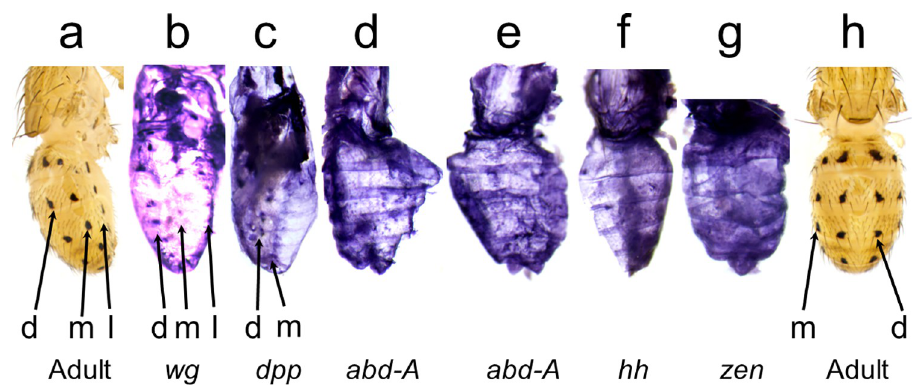
Fig 5. The mRNA expression patterns of wg and dpp show correlation with y expression in adult D . deflecta . a, h, Adult D . deflecta lateral and dorsal view. b, c, Lateral view. Developmental gene expression patterns of wg and dpp at pupal stage P7 in D . deflecta foreshadow distinct subsets of the adult abdominal color pattern. d-g, Dorsal view. abd-A , hh , and zen are not expressed along the dorsal midline of P9 and P10 pupae. ISH was performed on pupae at stages P6 –P10 to screen for the mRNA transcripts of each gene.